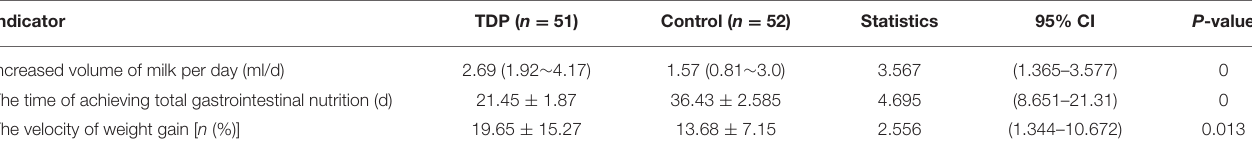
TABLE 2 | Comparison between the two groups after treatment between the two